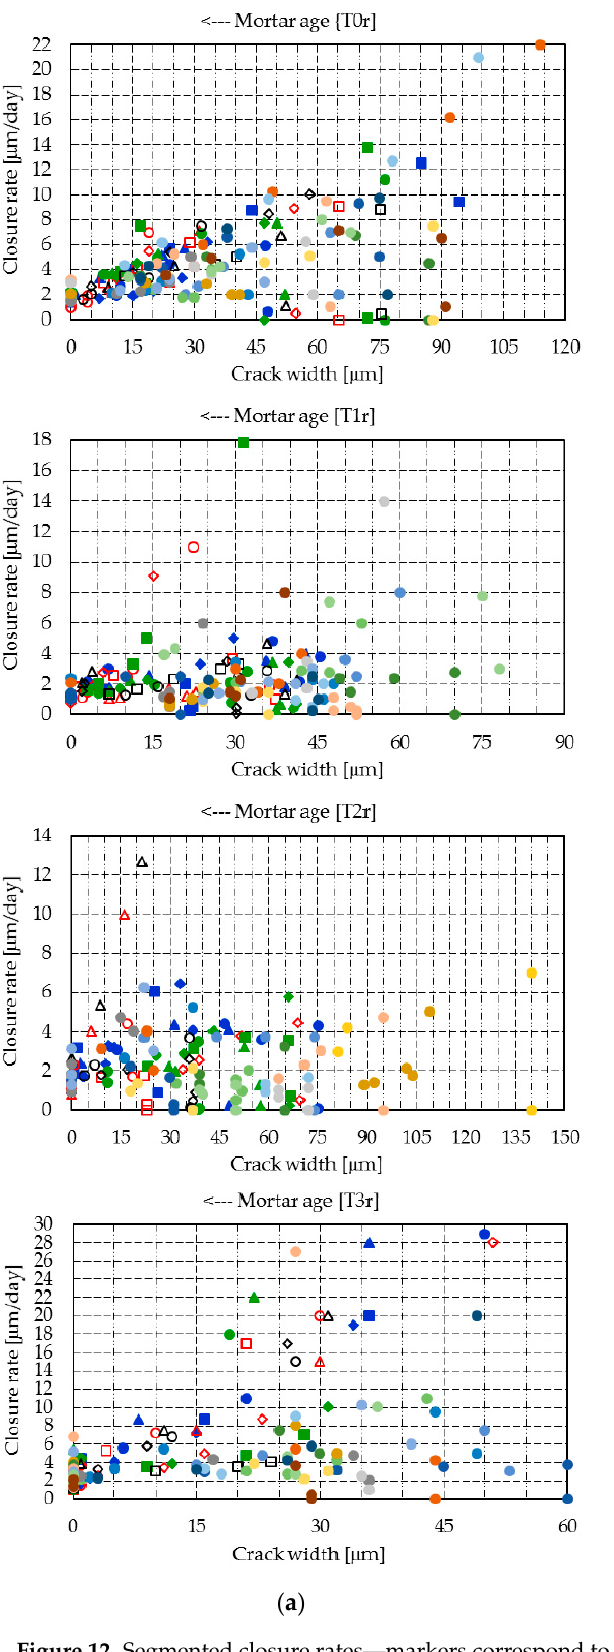
Figure 12. Segmented closure rates—markers correspond to the readings of each crack segment: ( a ) T0r–T3r; ( b ) T0c–T3c.